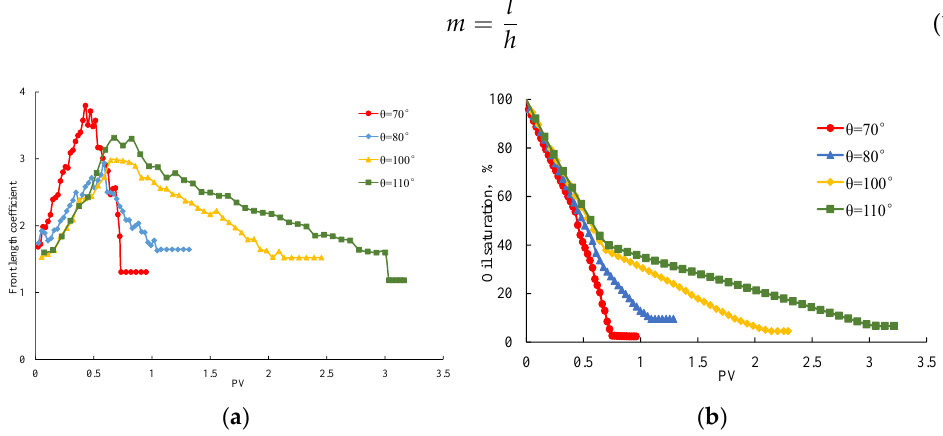
Figure 3. ( a ) Front length coefficient m and ( b ) oil saturation vs. PV for different wettability.